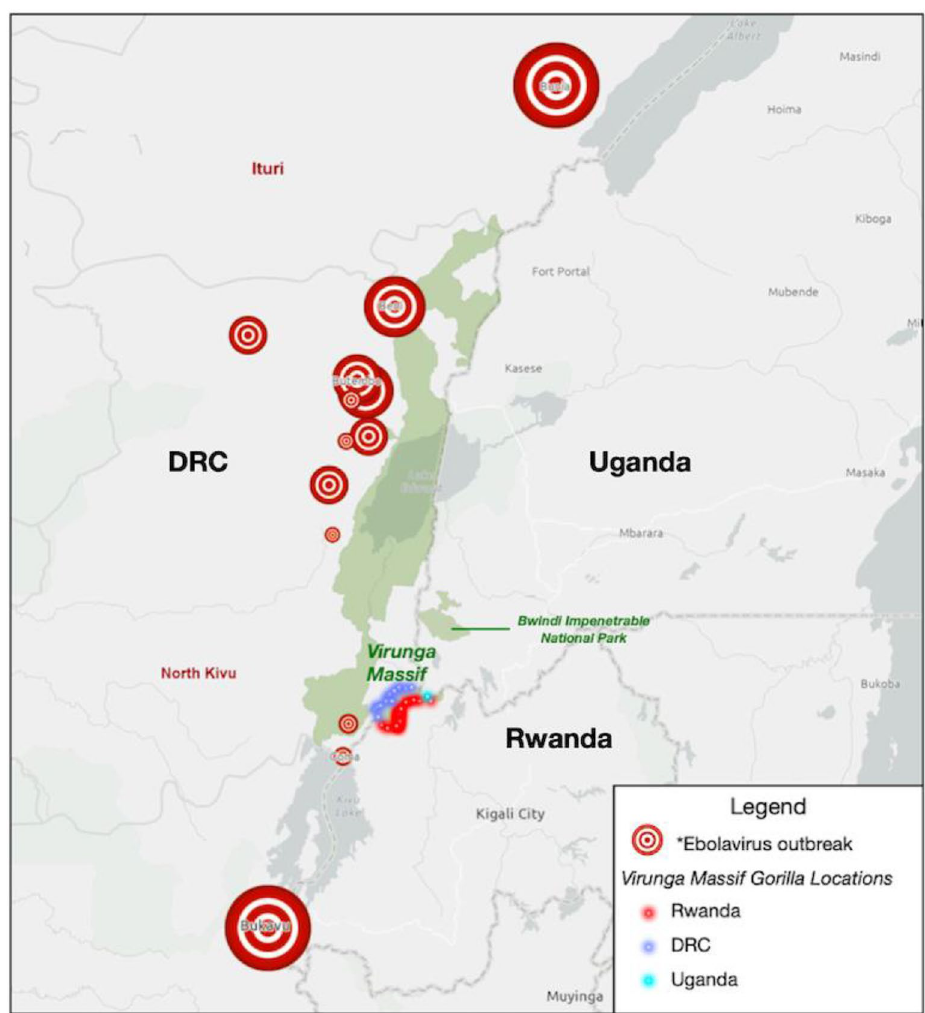
Figure 2. Locations of 2018–2021 human Ebola virus cases in the Democratic Republic of Congo (DRC) in proximity to the Virunga Massif and Bwindi mountain gorilla habitats. Outbreak data from: Centers for Disease Control and Prevention (2022). Map created with ArcGIS Online (Version 2.8), Esri Inc. https:// www. esri. com/ en- us/ arcgis/ produ cts/ arcgis- online/ overv iew. *size of circle represents size of Ebola virus outbreak in local geographic